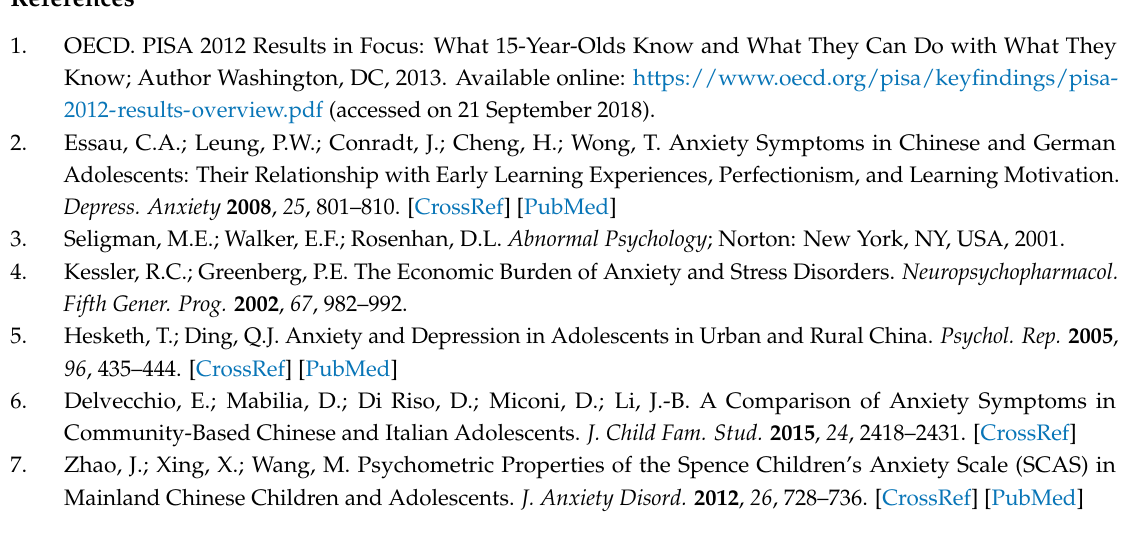
Supplementary Materials: The following are available online at http://www.mdpi.com/1660-4601/15/10/ 2087/s1. Table S1: Correlation between student standardized MHT scores and selected student characteristics using sampling weights, Table S2: Correlation between student standardized MHT scores and selected student characteristics by gender and level of